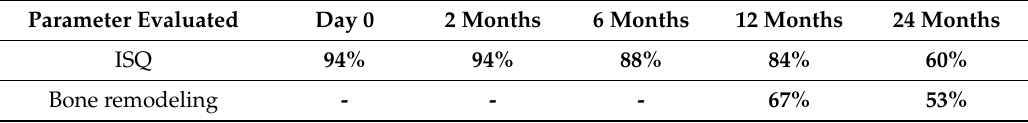
Table 2. Statistical power according to parameter and evaluation stage.